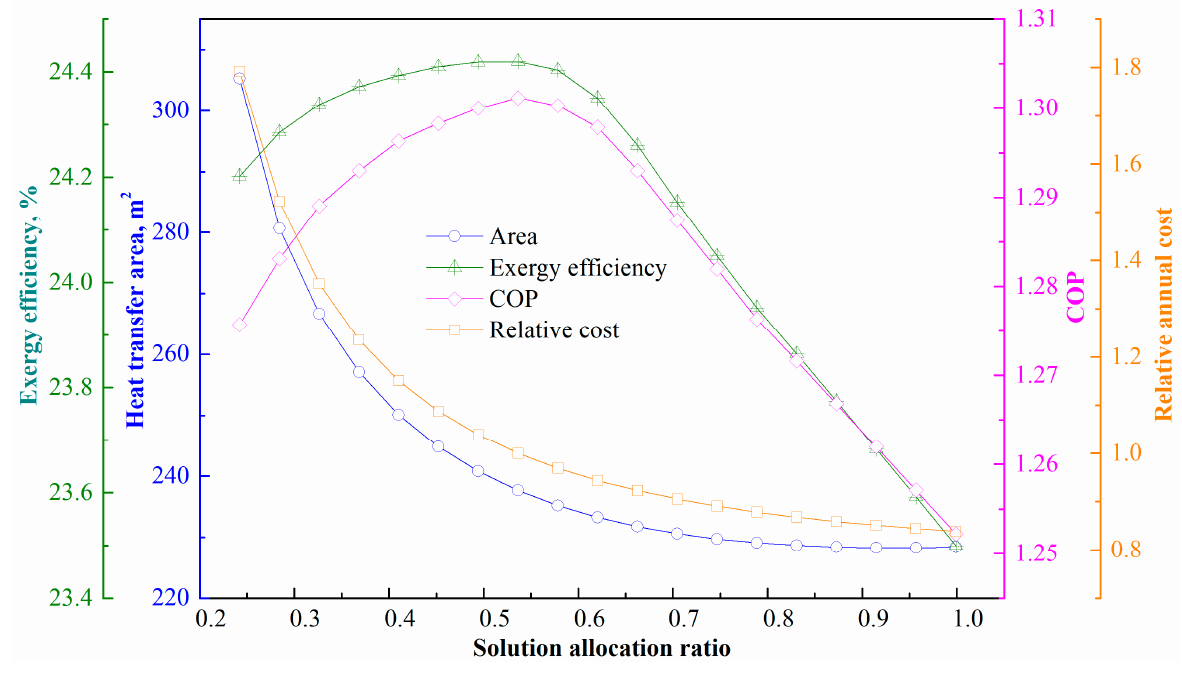
Figure 11. Variation of performance with parallel connected chiller as function of solution allocation ratio. allocation